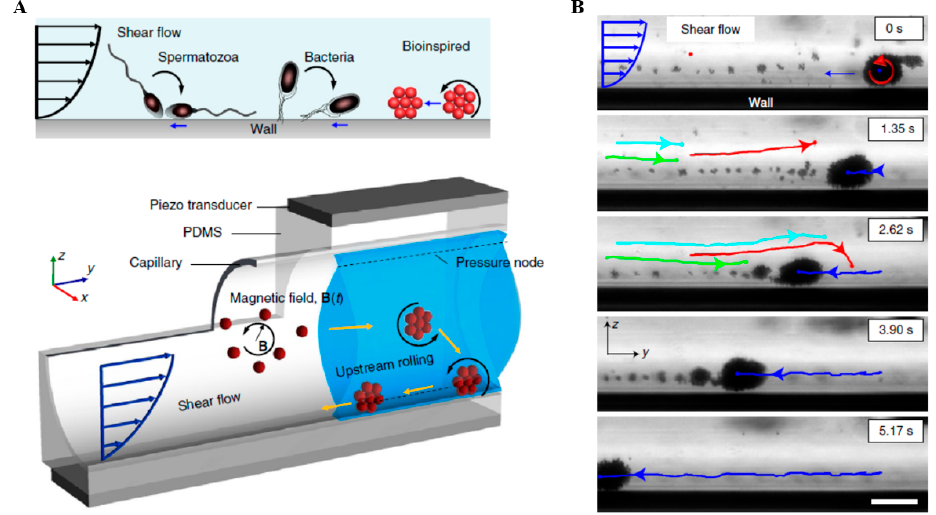
Figure 10. Bioinspired acoustic-magnetic microswarm robots. ( A ) Superparamagnetic particles self-assemble into a spinning microswarm due to the dipole-dipole interaction of a rotating magnetic field. The microswarm was marginalized towards the wall due to the presence of acoustic pressure nodes. ( B ) Image sequences demonstrate the rheotaxis of a microswarm rolling along the wall of the capillary in a combined acoustic and magnetic field. The streamlines of the oppositely directed flow are shown by different colored trajectories. Scale bar = 60 μ m. Reproduced with permission from Ref. [90].